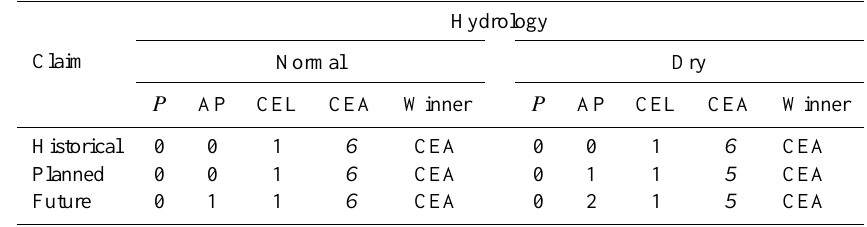
Figure 6. Satisfied annual water claim (%) of the riparian provinces based on different bankruptcy solution methods for different claims and hydrologies: (a) historical claim in a normal year, (b) historical claim in a dry year, (c) planned claim in a normal year, (d) planned claim in a dry year, (e) future claim in a normal year, and (f) future claim in a dry year.